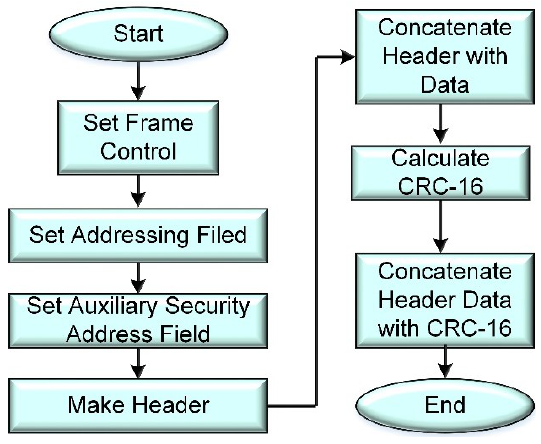
Figure 9. Flowchart for wrapping the IP packet